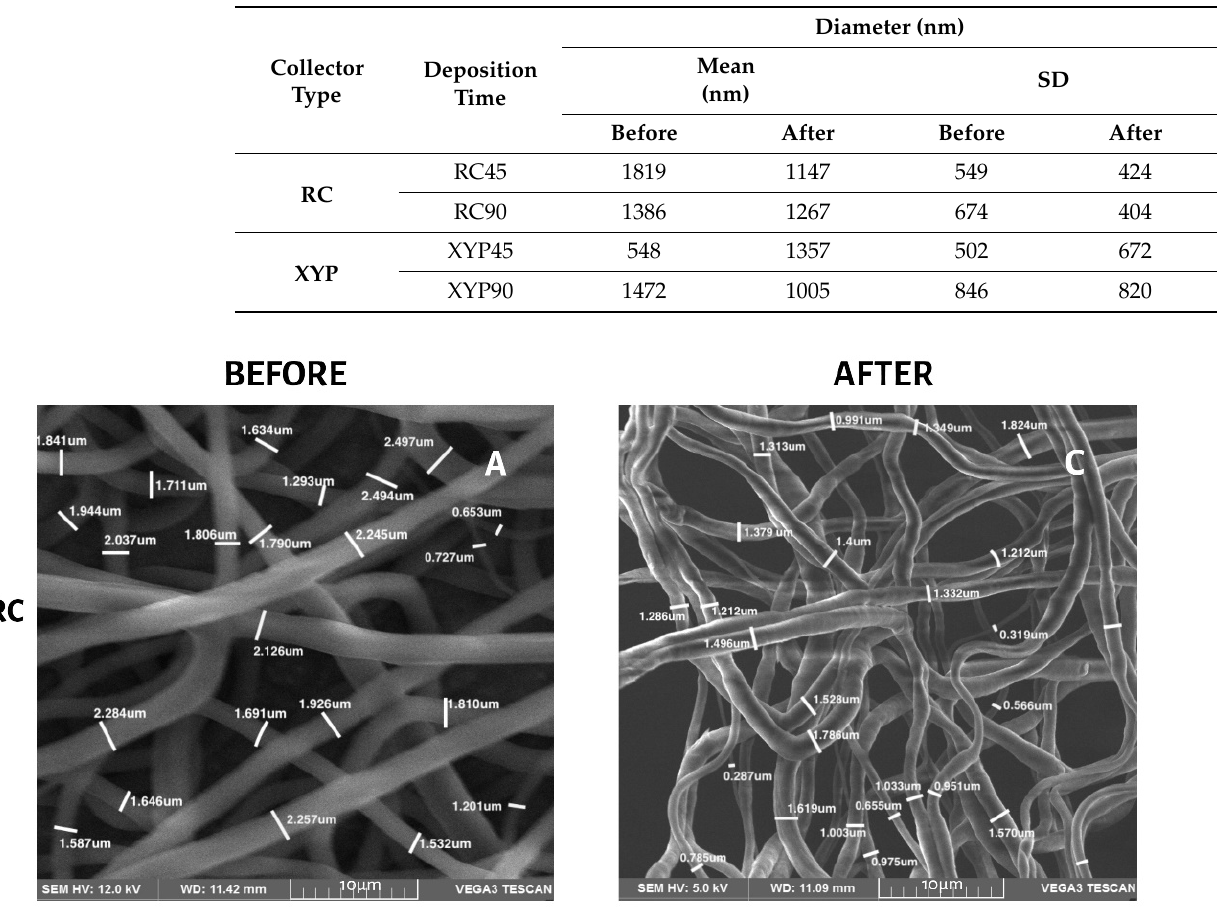
Table 3. Diameter and statistics of different fibers of the samples collected using RC and XYP before and after mechanical testing.